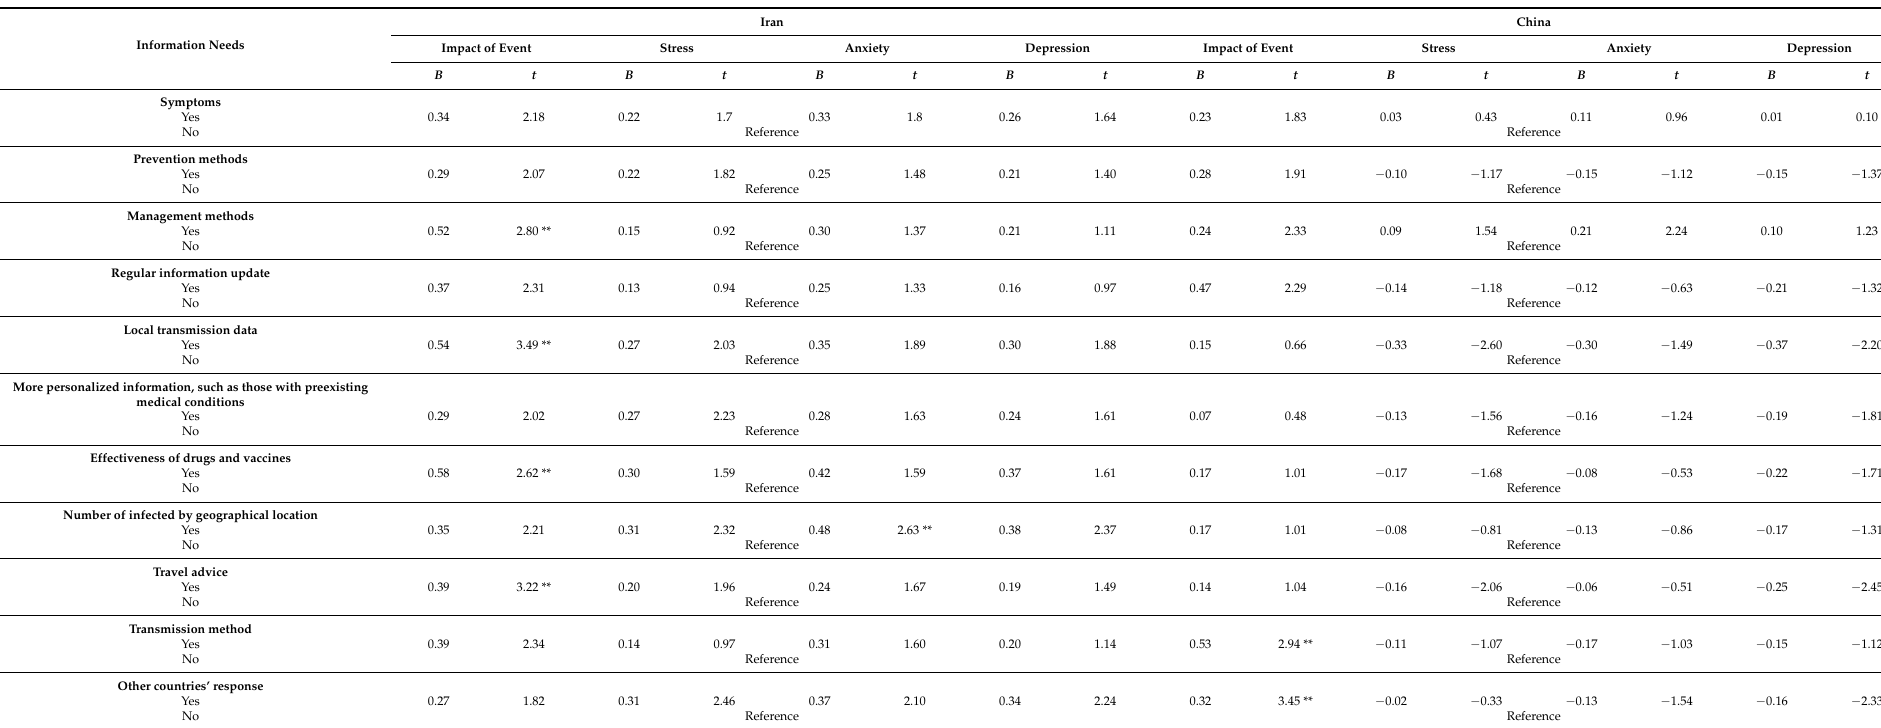
Table 5. The linear regression analysis between the needs for COVID-19 information and metal health parameters in Iranian and Chinese participants ( n = 1411). Iran China InformationNeeds ImpactofEvent Stress Anxiety Depression ImpactofEvent Stress Anxiety